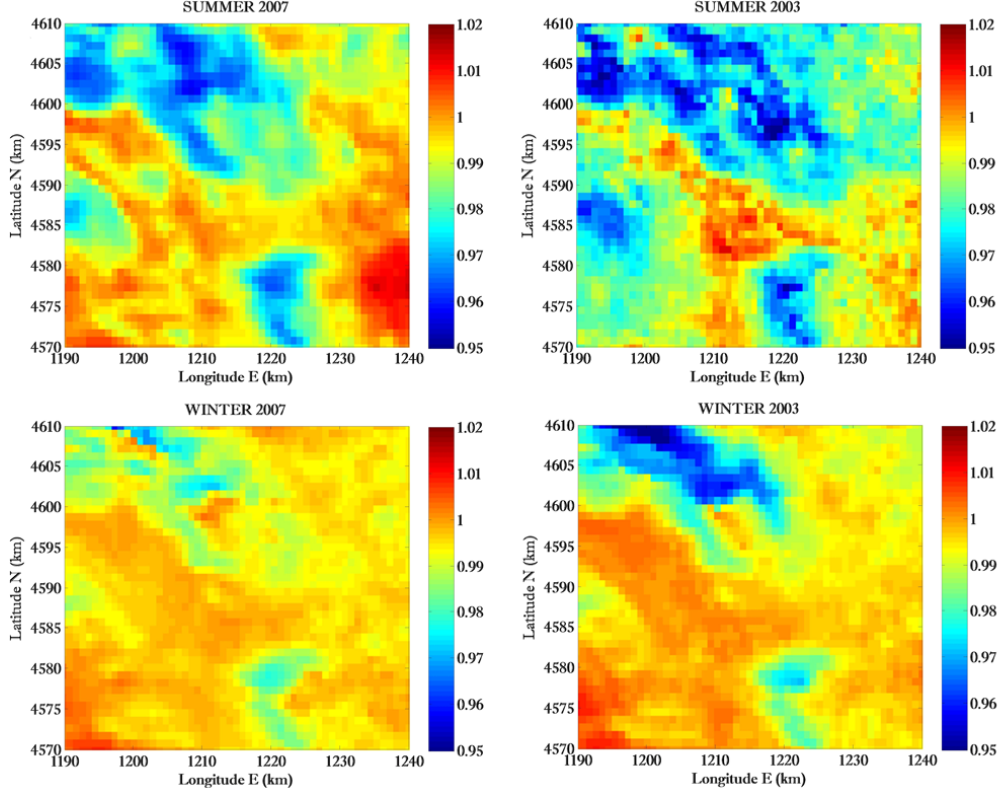
Fig. 4. Spatial pattern of the winter and summer average of the daily ratio r in 2003 and 2007.